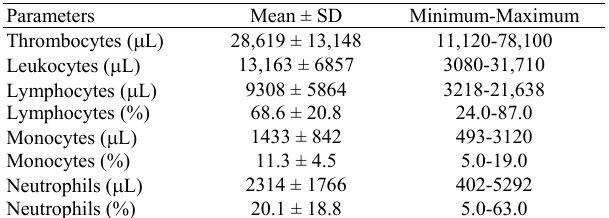
Table 2. Mean values ± Standard deviation (SD), and minimum and maximum for total thrombocyte and leukocyte counts of C . temensis (n = 40) farmed in central